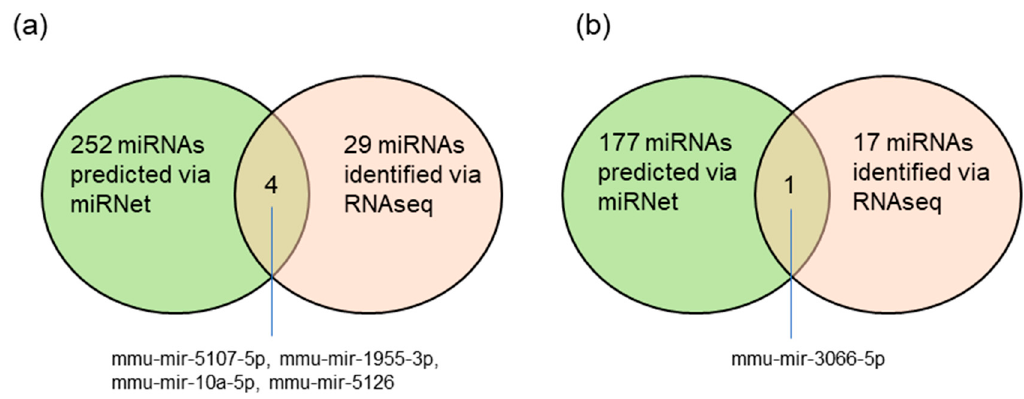
Figure 6. Venn diagrams indicating the shared miRNA genes between miRNet-predicted miRNAs and RNA sequencing-identified miRNAs. ( a ) Total splenocytes. ( b ) Splenic neutrophils.